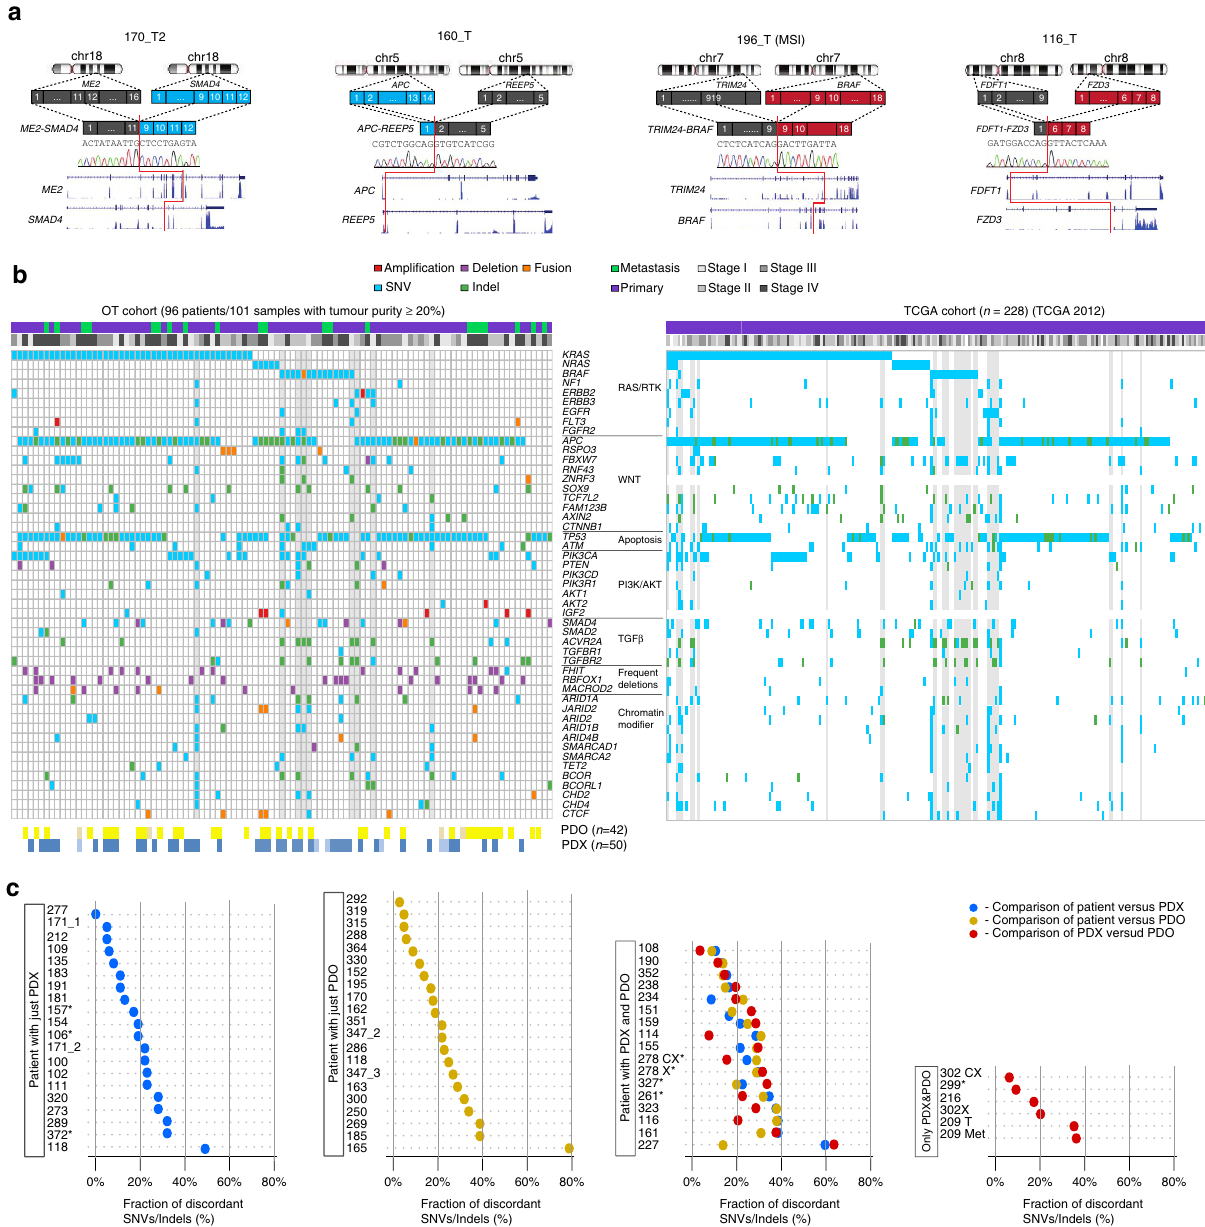
0% 20% 40% 60% 80% 0% 20% 40% 60% 80% (%)Fraction of discordant Fraction of discordant (%)Fraction of discordant SNVs/Indels (%) SNVs/Indels SNVs/Indels Figure 2 | Genomic landscape of the OTpatient and model cohorts. ( a ) Examples of gene fusions, either deleterious ( ME2-SMAD4 and APC-REEP5 , blue) or activating ( TRIM24-BRAF and FDFT1-FZD3 , red); schematics display chromosomal location, fusion partners, exon structure (blue, red and grey filled boxes), fusion breakpoint (red line), validation by Sanger sequencing and RNA read coverage. ( b ) Landscape of the most recurrent somatic alterations in 101 OTprimary and metastasis samples (tumour purity of Z 20%) from 96 patients compared with the mutation pattern in 228 primary CRC tumours from TCGA (ref. 25) (SNV þ Indel). Genes are grouped according to biological pathways. MSI and hypermutated samples are shaded in grey. Tumour stages are coded in grey shades on top of the matrix. Metastasis and primary samples are indicated respectively in purple and green boxes on top of the matrix. Alteration types are colour-coded as indicated. Obtained PDX and PDO models are depicted in blue and yellow, respectively at the bottom of the matrix. Darker shades correspond to the models shown in Fig. 2c. ( c ) Fraction of damaging and expressed somatic SNVs/Indels found discordant between original patient tumours and matched models, comparing 56 patient samples (tumour purity Z 40%) and their corresponding ex vivo models (37 PDX and 37 PDO), as well as five PDX-PDO siblings without matching patient samples. Dot colours indicate the following: patient versus PDX (blue), patient versus PDO (yellow) or PDX versus PDO (red). Samples described in Fig. 3b are marked in bold. MSI and hypermutated samples are marked with an asterisk. Panels from left to right: patients with an established PDX only; patients with an established PDO only; patients with established PDX and PDO; PDX/PDO siblings without a corresponding sequenced patient tumour. In the cases of tumours 278 and 302, the suffix ‘X’ represents patient-derived PDX and ‘CX’ represents PDO-derived PDX.